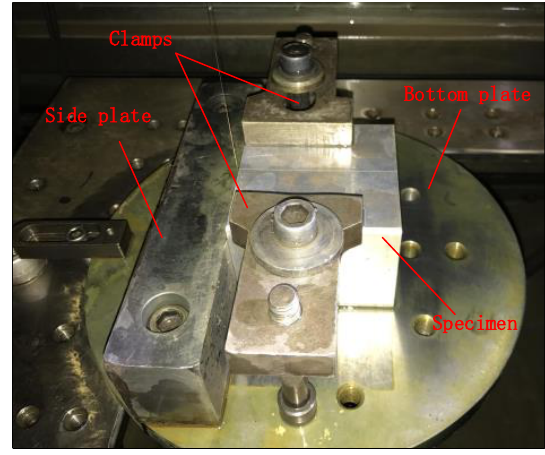
Figure 5. “L” shape fixture system.